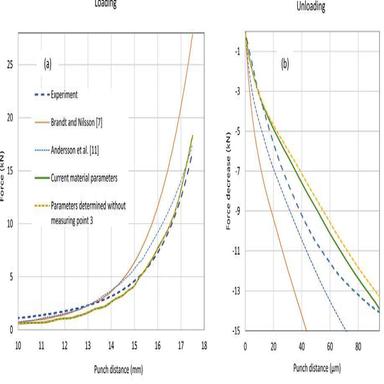
(a) Pressing force from experiment and simulation for the cylinder geometry with hole shown in (b) Force decrease during unloading for the cylinder geometry with hole.